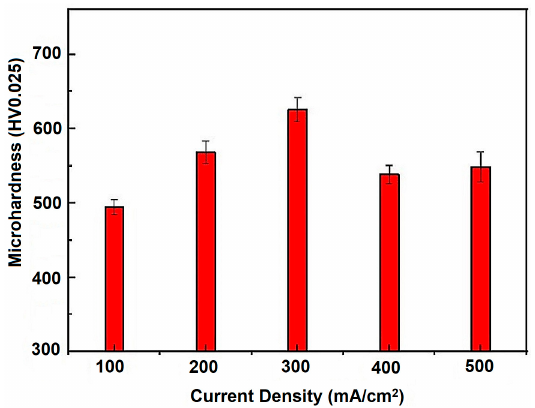
Figure 6. Microhardness of the coatings at various current densities.